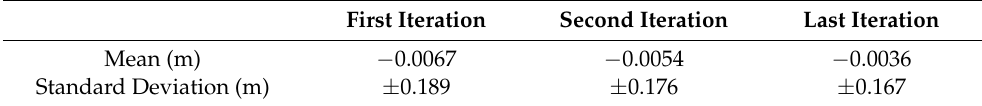
Table 3. Differences between individual tree models to be validated and reference models.